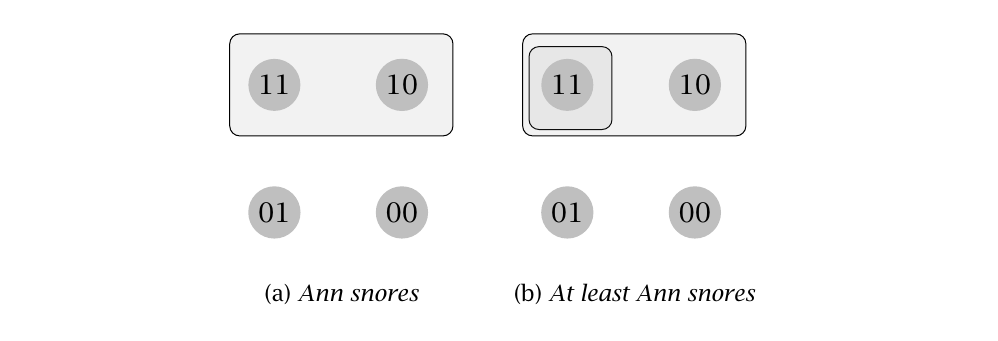
Figure 2 Attentive and non-attentive